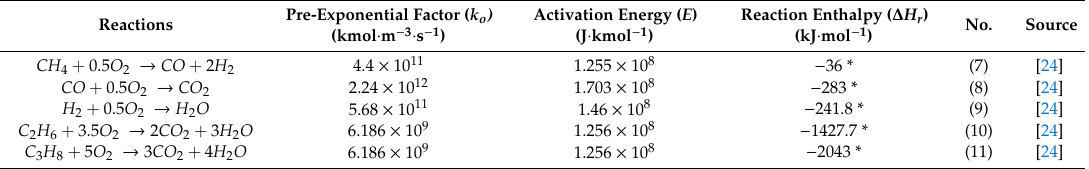
Table 2. Species reactions for combustion of NG and H 2 along with kinetic and thermodynamic